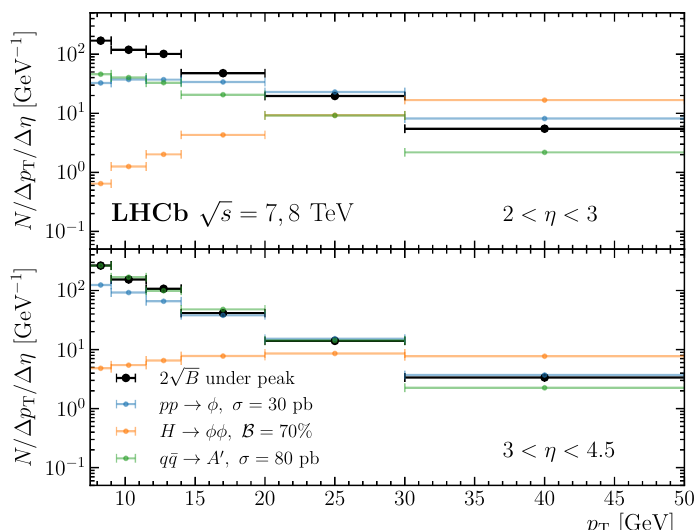
Figure 1 . The expected sensitivity, de(cid:12)ned as 2 p B , where B is the background under a dimuon peak with invariant mass 11 GeV, is shown for the 12 [ p T ; (cid:17) ] bins. For comparison, signal yields in the various bins are shown for three di(cid:11)erent production mechanisms: a (cid:30) boson produced via gluon-gluon fusion, a (cid:30) boson coming from a H (cid:30)(cid:30) decay and a vector A 0 boson produced via ! the Drell-Yan